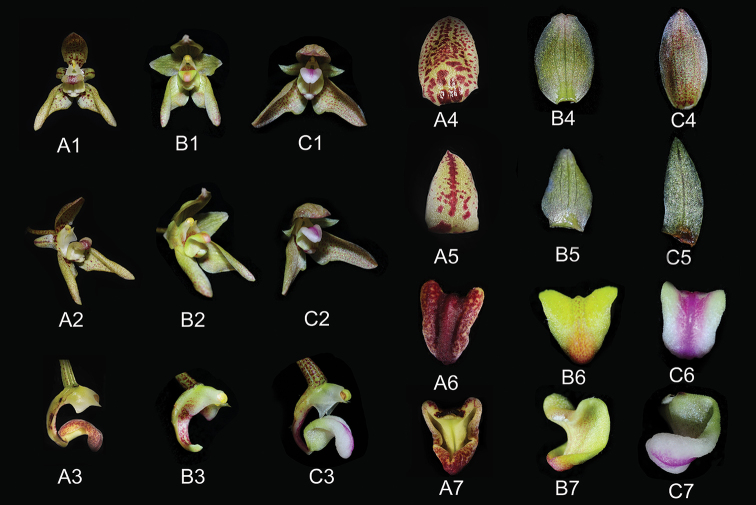
ABulbophyllum
reflexipetalumBB.
umbellatumCB.
salweenensis1 front view of flower 2 lateral view of flower 3 lateral view of column and lip 4 dorsal sepal 5 petal 6 front view of column 7 dorsal or lateral view of labellum (Photographed by J.-D. Ya & H. Jiang).